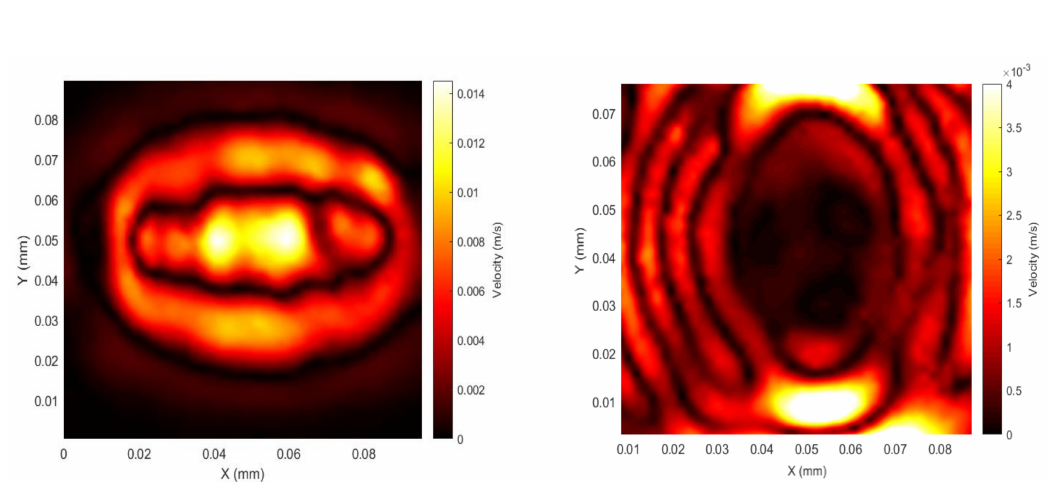
Figure 9. Patch spatial scan for the magnitude of the surface velocity at the beginning of the first peak of the signal (left, t = 14 µ s) and the end of the pulsed wave (right, t = 22 µ s) for configuration 1; f = 120 kHz, 1 cycle sine